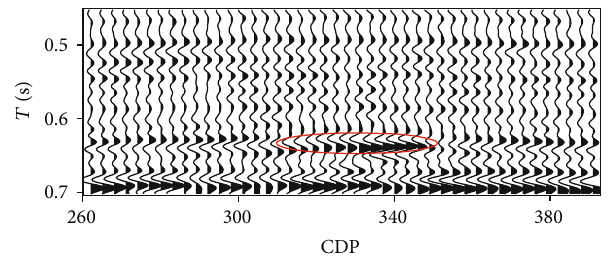
Figure 5: Stack section of a fi eld dataset from HampsonRussell software. The seismic traces are shown with the intervals of 3. The red circle highlights the location of the gas